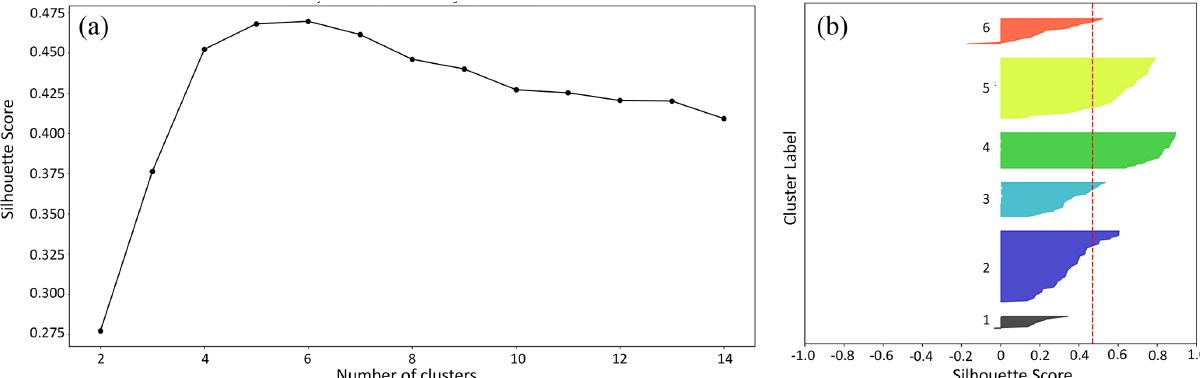
Figure 9. (a) Average silhouette score for agglomerative clustering performed using cosine distances. (b) Silhouette analysis for agglomer- ative clustering performed using cosine distances on data with n clusters = 6.